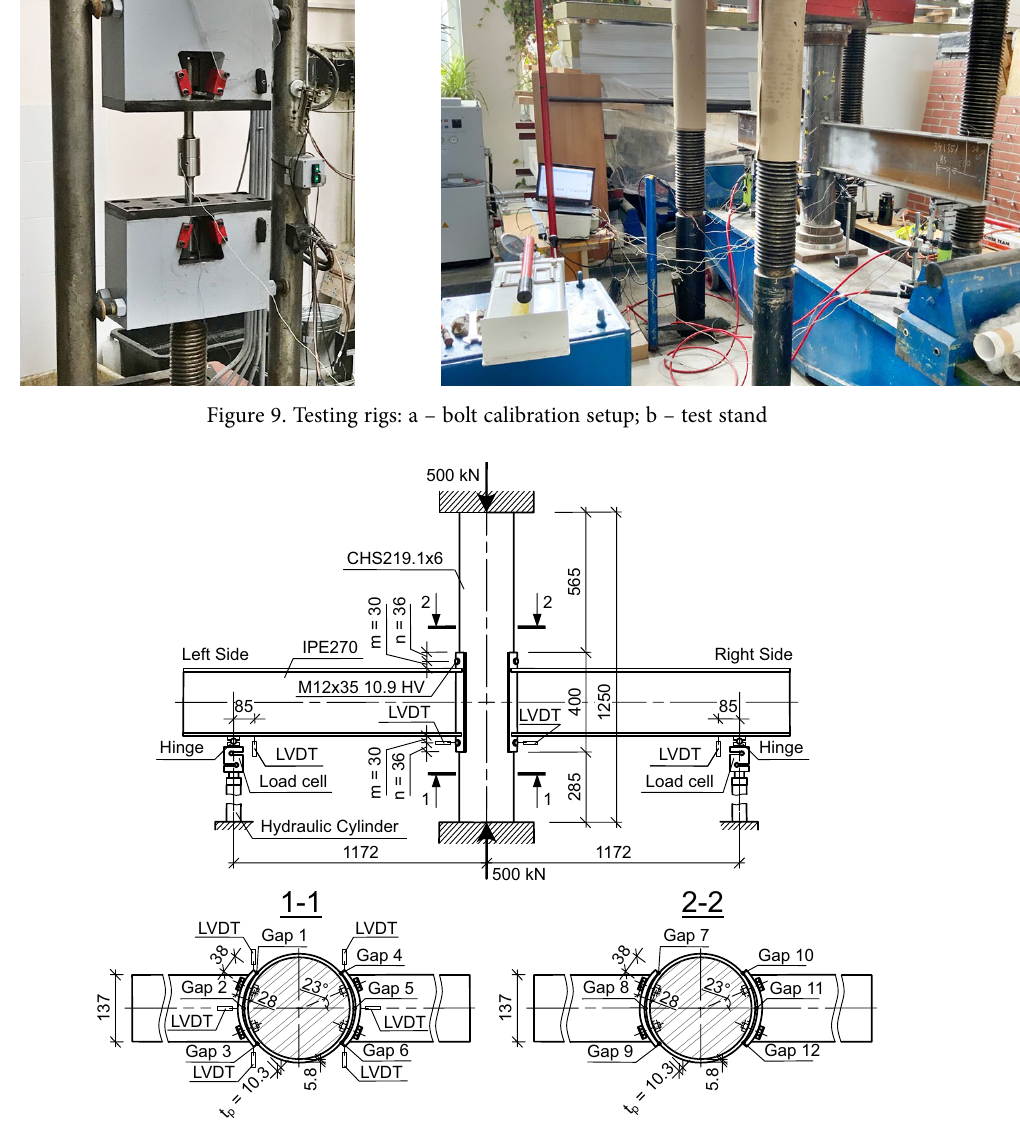
Figure 10. Geometry of the